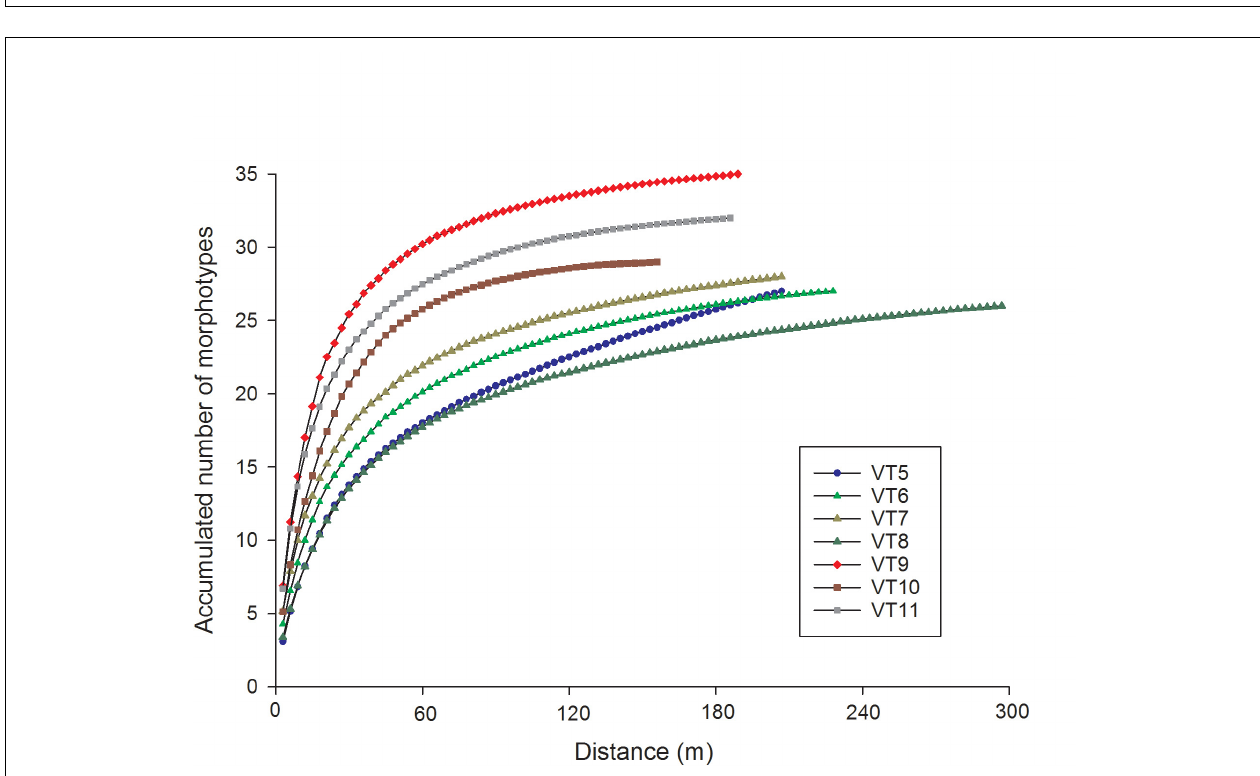
FIGURE 3 | Density (individuals.m − 2 ) of the different phyla observed during the photo transects on Mohn’s Treasure.